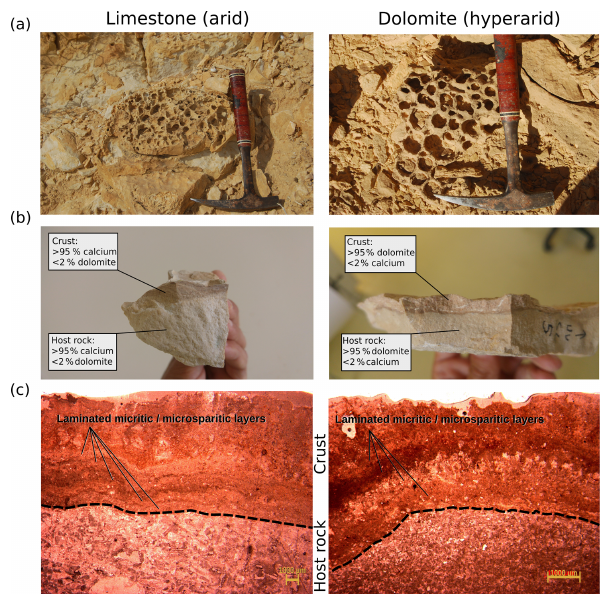
Figure 1. (a) Comparable weathering features in the exposed lime- stone and dolomite rocks at both sites as noted in field outcrops (hammer for scale, 30cm long). (b) Visual presence of a rock crust with similar thickness (3–6mm) in both rock types. The crust’s mineralogical composition matched that of the host rock. (c) Thin- section analysis of the rocks showing lamination structure in the BRCs. Dashed lines indicate the interface between BRC host rocks. BRC’s mineralogy includes micritic to microsparitic dolomitic or calcitic crystals.